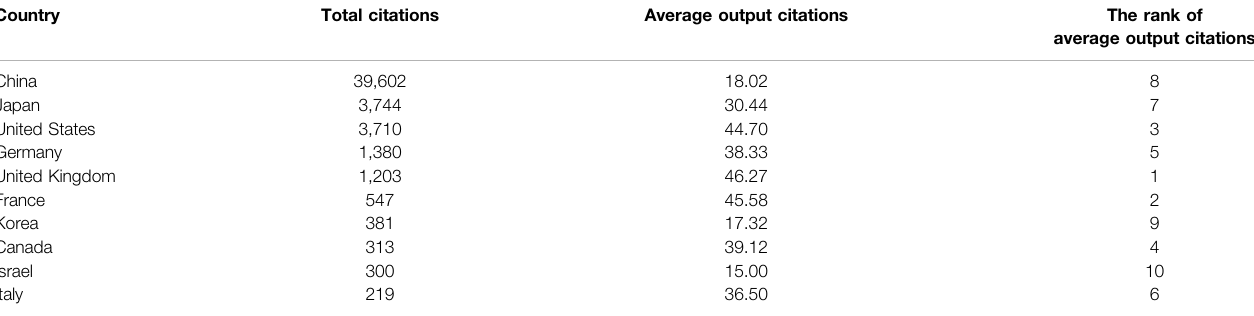
TABLE 4 | The top 10 countries whose outputs had the largest number of citations and their corresponding average number of citations per output. Country